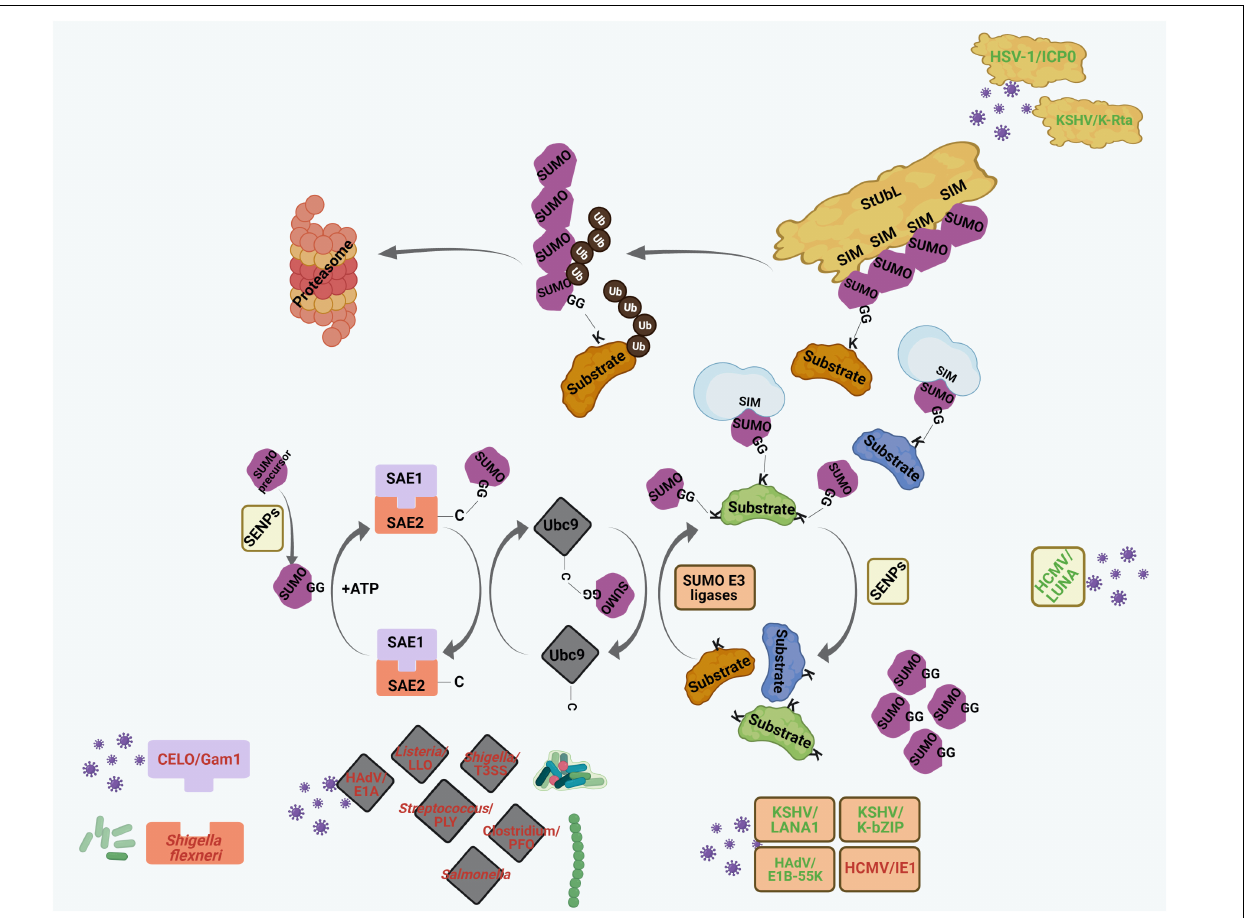
FIGURE 4 | Interplays between different pathogenic components and host cellular SUMO machinery regulating PML NB integrity. Many viral and bacterial factors manipulate with the host cellular SUMO conjugation/deconjugation system to modulate PML NBs. The process of SUMO conjugation and deconjugation as in Figure 2 is shown here. Components of different pathogens are represented within specific colored shapes which are look-alike with their targets within the SUMO system (such as E1, E2, E3, SENPs, and StUbLs). The components which mimic targets within the SUMO machinery are text-colored green whereas those which destabilize/antagonize targets within the SUMO system are text-colored red. For further details, please refer to the main body of the